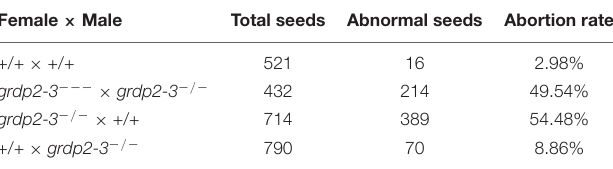
TABLE 1 | Analysis of seed development in siliques from selfing and reciprocal crosses of grdp2-3 plants. Female ×